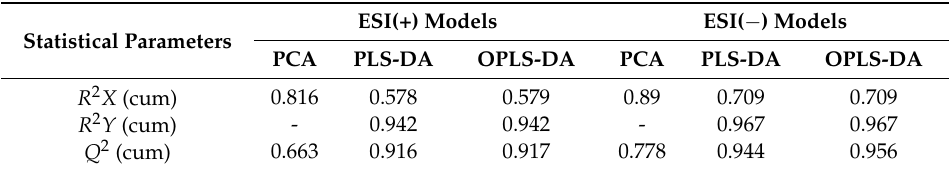
Figure 3. ( A , B ) PLS-DA model built with positive ionization data ( R 2 X = 0.578, R 2 Y = 0.942, Q 2 = 0.916) and negative ionization data ( R 2 X = 0.709, R 2 Y = 0.967, Q 2 = 0.944). In both ionization modes these three varieties were clearly separated. Red dots: Einkorn (ID331). Green dots: Emmer (Garfagnana). Blue dots: Spelt (Rouquin). Table 1. Statistical values for PCA, PLS-DA, OPLS-DA models. R 2 X (cum) and R 2 Y (cum) represent the variance of the x and y variables explained by the model, while Q 2 is the cumulative predicted variation in the Y matrix.